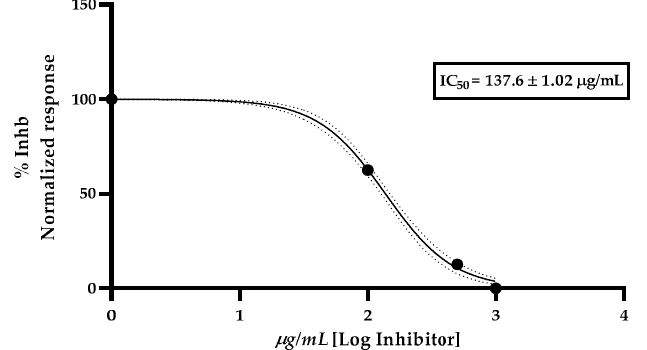
Figure 1. Inhibitory effect plot of H . strigosum , EO, against Acetylcholinesterase. Data represent the media of three replicas and three different experiments analyzed by non-linear regression method.